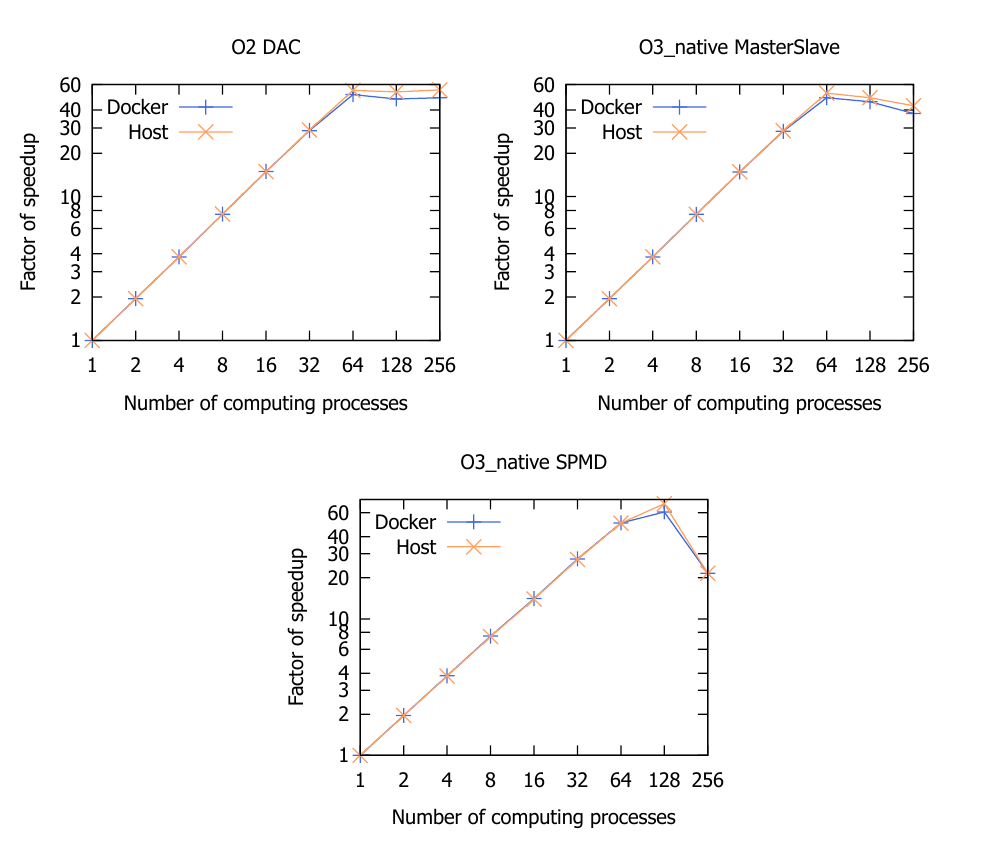
Figure 13. Speed-up execution time of programs for computing processes. Table 7. Speed-up execution time of programs for computing